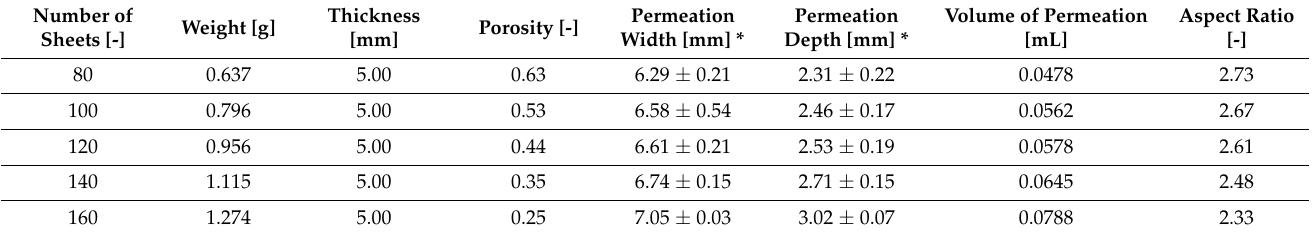
Figure 3. Cross-sectional observation of the samples permeated with dye solution. ( A ) 80-ply laminated product, ( B ) 100-ply laminated product, ( C ) 120-ply laminated product, ( D ) 140-ply laminated product, and ( E ) 160-ply laminated product. Table 3. Dye solution permeation results for the samples made of nonwoven fabric through CO 2 - assisted polymer